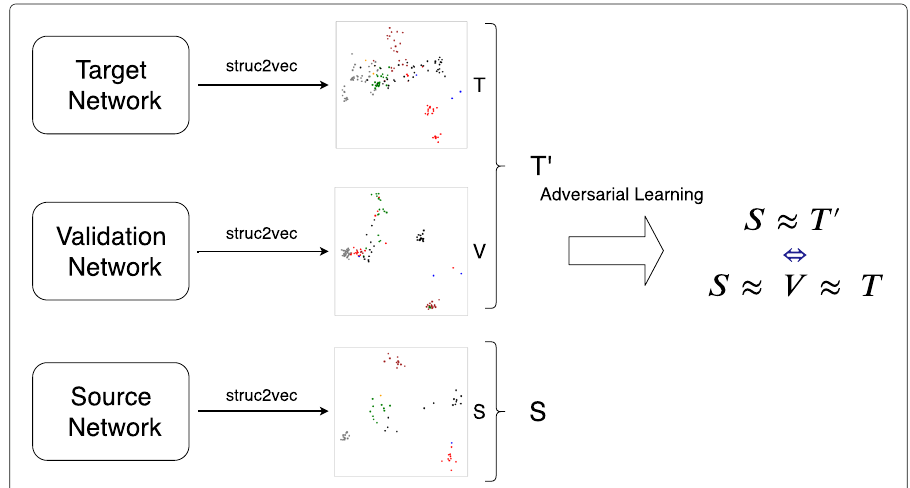
Fig. 2 Model selection using validation